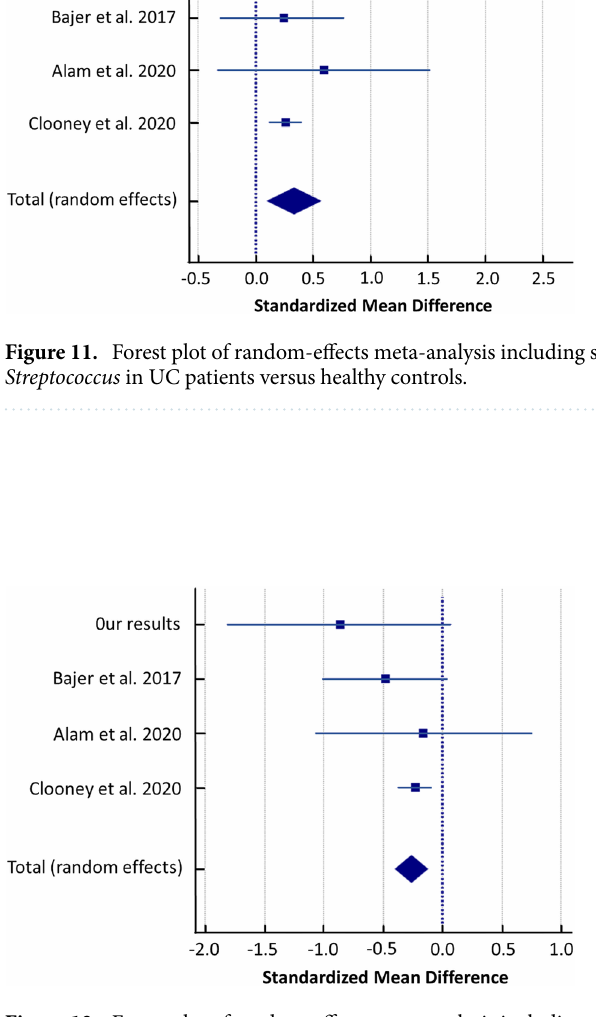
Figure 12. Forest plot of random-effects meta-analysis including studies evaluating the abundance of Ruminococcus in UC patients versus healthy